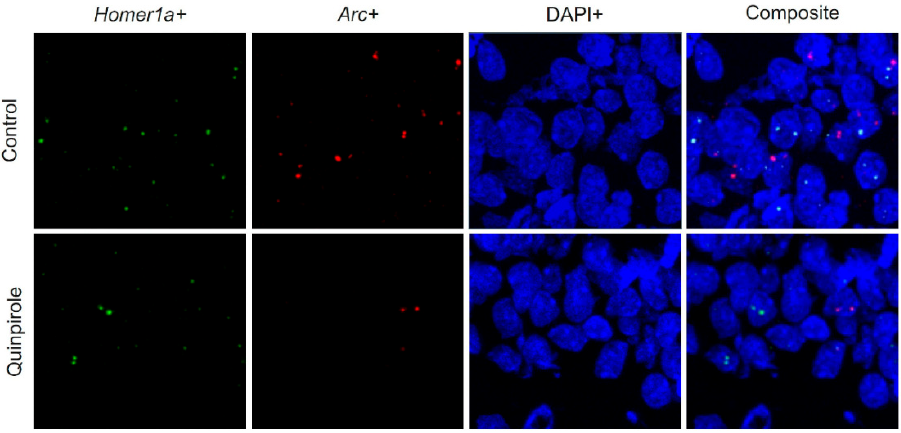
Figure 3. Representative images of immediate early gene (IEG) expression in CA1 area of hippo- campus.